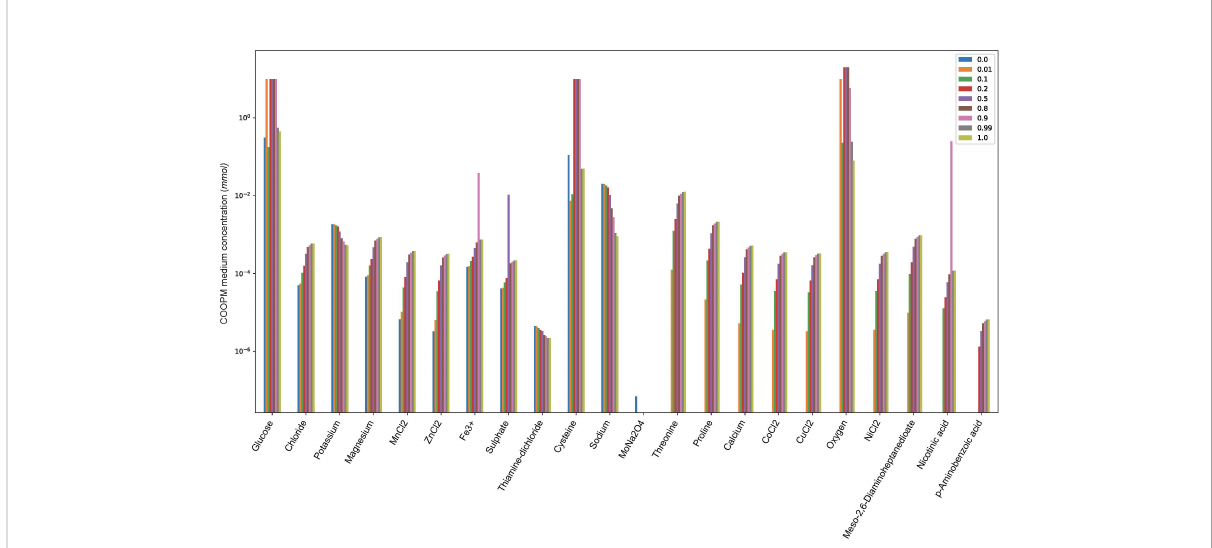
FIGURE 5 The changes of a ∈ (0, 1) and the required amount of metabolites in COOPM (poor medium) to produce 10% of community MBR as the community objective function is de fi ned by a % MBR DP + (1 − a )% MBR SA . a = 0 and a = 1 mean that the optimization function is the maximization of S. aureus and D. pigrum , respectively. For instance, if we look at threonine, we do not see any blue color, which was indicated for a = 0. This means that if the objective function in the community with poor nutrients is de fi ned only by the maximization of S. aureus , the change of this metabolite does not play an important